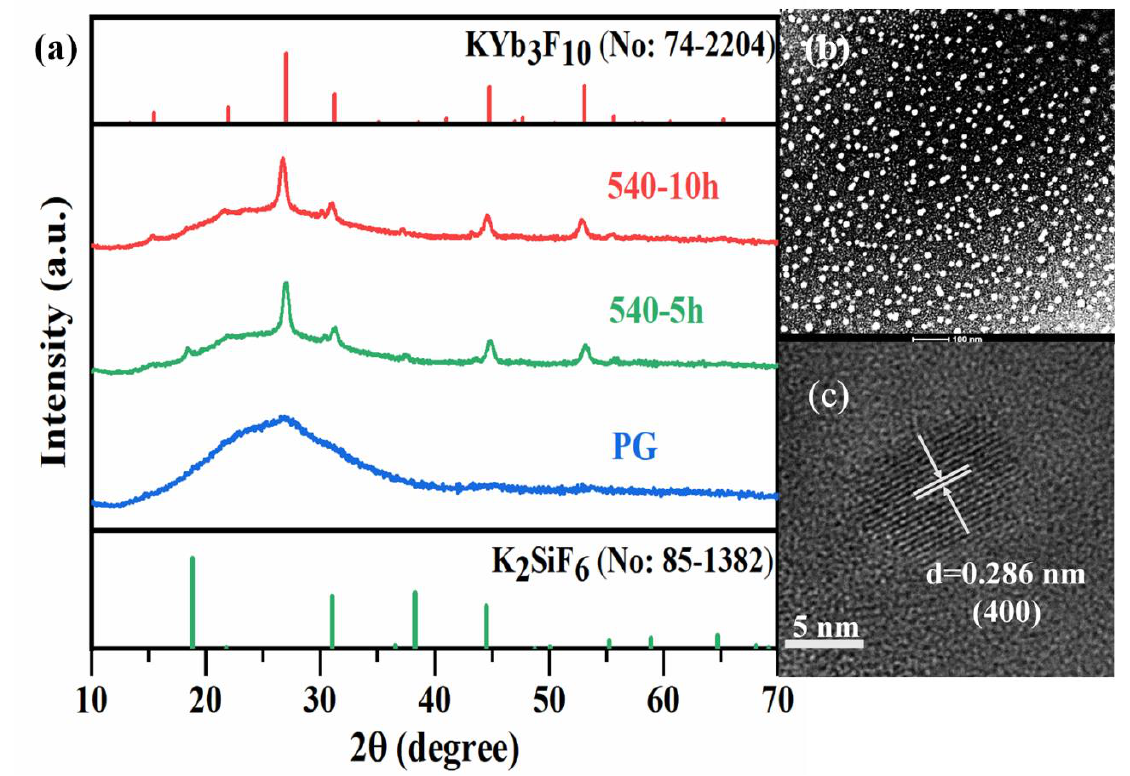
Figure 1. ( a ) XRD patterns of 1.0Yb 3+ ‐ 0.005Tm 3+ co-doped PG and GCs. ( b ) TEM and ( c ) HRTEM images of 1.5Yb 3+ ‐ 0.1Tm 3+ co ‐ doped GC heat treated at 540 °C for 10 h.